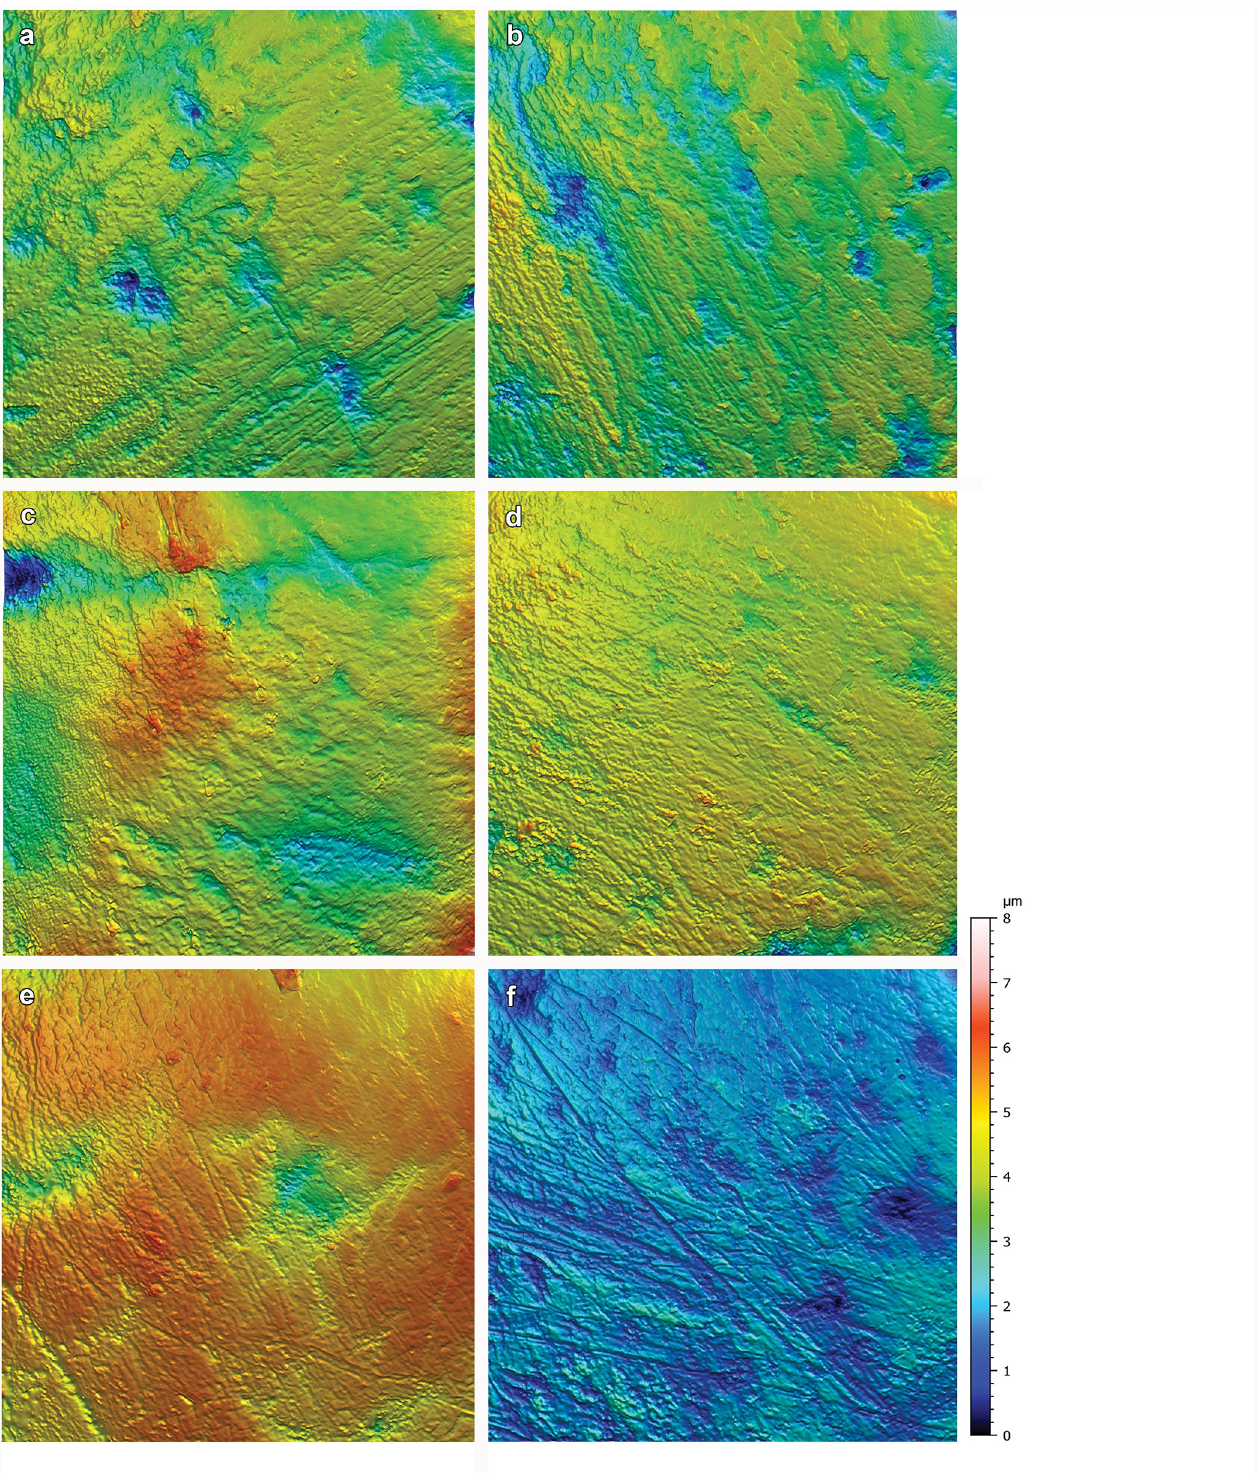
Fig 2. Surface texture (coloured) meshed axiomatic models for species used in the ANOVA. 3D top view normalized in XYZ, 100% resolution, tile size = 160x160 μ m; (a) Stereognathus ooliticus (GLRCM 2104); (b) Oligokyphus major (BRSUG 26300); (c) Stereognathus sp. (ZIN PH 64/117); (d) Stereognathus sibiricus (ZIN PH 9/154); (e) Kayentatherium wellesi (MCZ 8811); (f) Dinnebitodon amarali (MCZ 8830–1). Color scale corresponds to height on the z-axis with red representing higher elevations and blue lower elevations.